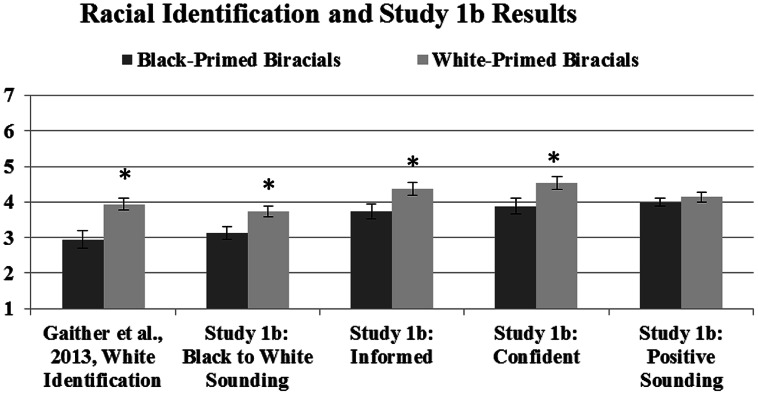
These means show the original self-reported racial identification of Black- and White-primed biracial participants from Gaither et al. (2013) in addition to Study 1b. Lower numbers reflect identifying with or sounding more Black; higher numbers reflect identifying with or sounding more White and more informed, more confident, and more positive sounding; error bars represent SE; ∗denotes significant differences between priming groups.